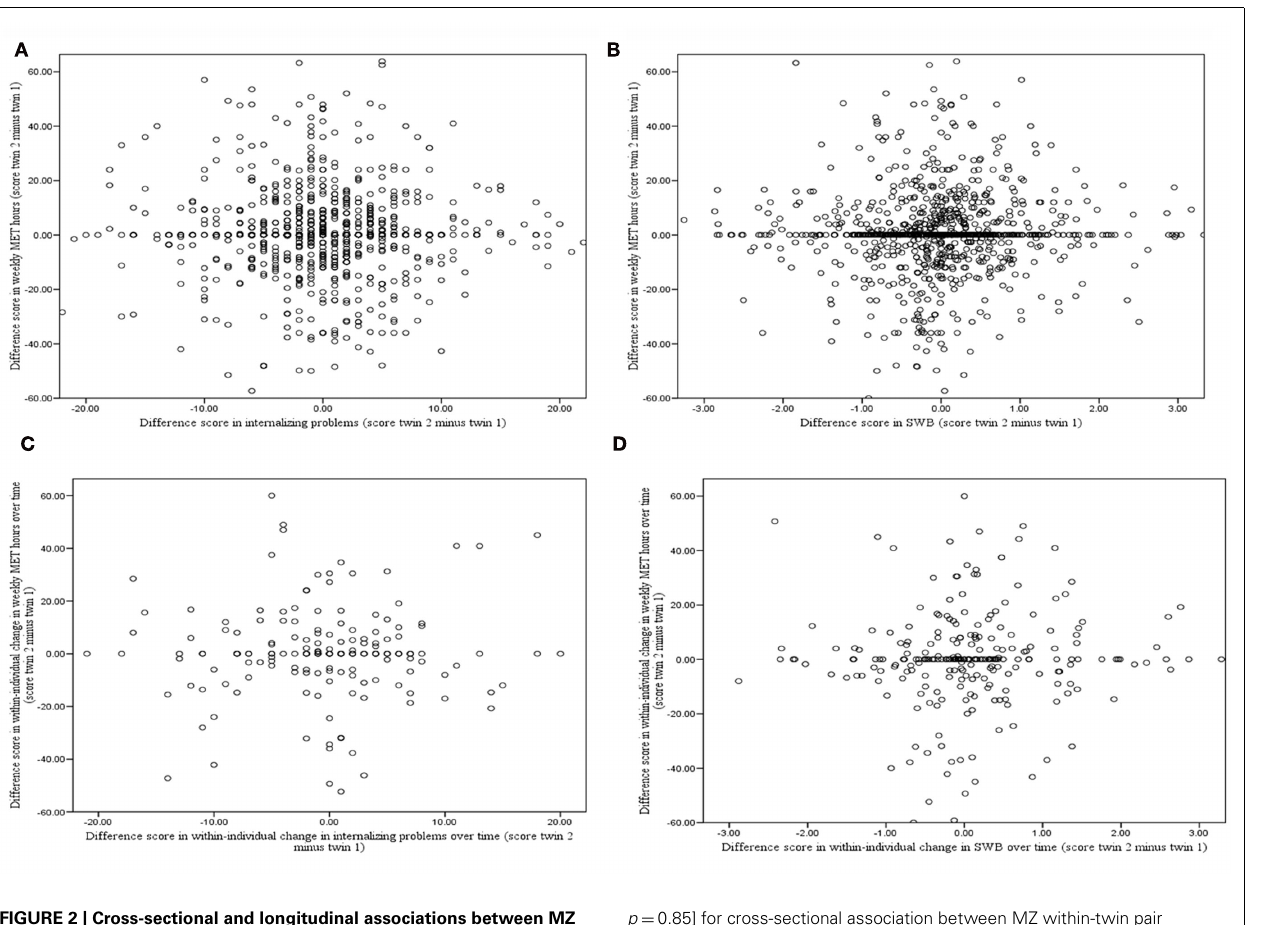
p = 0.85] for cross-sectional association between MZ within-twin pair difference in exercise behavior and SWB. (C) β = 0.07 [ χ 2 (1) = 0.915, p = 0.34] for longitudinal association between MZ within-twin pair differences in exercise behavior and internalizing problems. (D) β = 0.12 [ χ 2 (1) = 3.70, p = 0.06] for longitudinal association between MZ within-twin pair differences in exercise behavior and